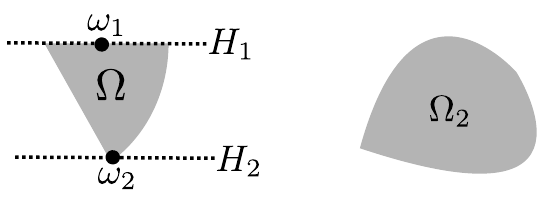
Figure 11: Assuming the Subspace Axiom, the bit state space Ω convex, i.e. cannot contain lines in its boundary like the convex set depicted on the left. Instead, it could look like the convex set on the